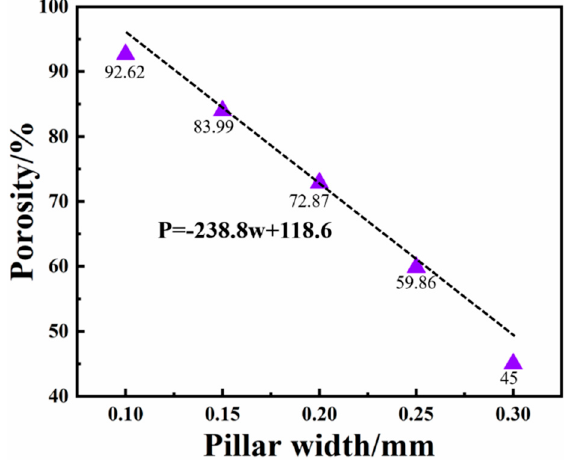
Figure 1. Correspondence between column width and porosity of gradient porous structure.